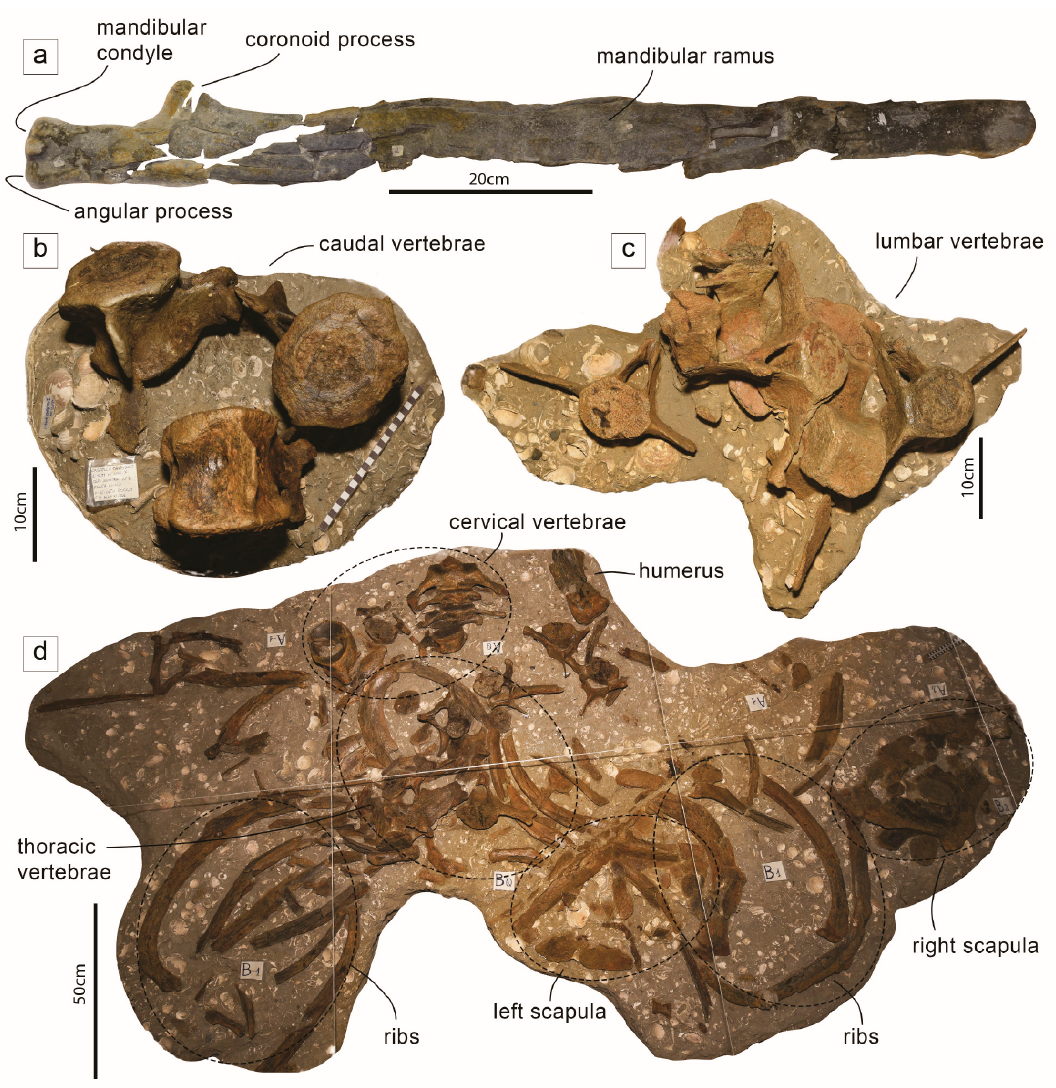
Figure 2. Skeletal portions of the ICCD 09 00000001-18 whale nicknamed Brunella. ( a ) Left dentary showing typical balaenopterid characters in the posteriorly-oriented mandibular condyle, reduced angular process and comparatively long distance between the condyle and the coronoid process; ( b ) group including caudal vertebrae 3 to 5; ( c ) group including disarticulated lumbar vertebrae; ( d ) large block including cervical and thoracic vertebrae, two scapulae, one humerus and most of the ribs.